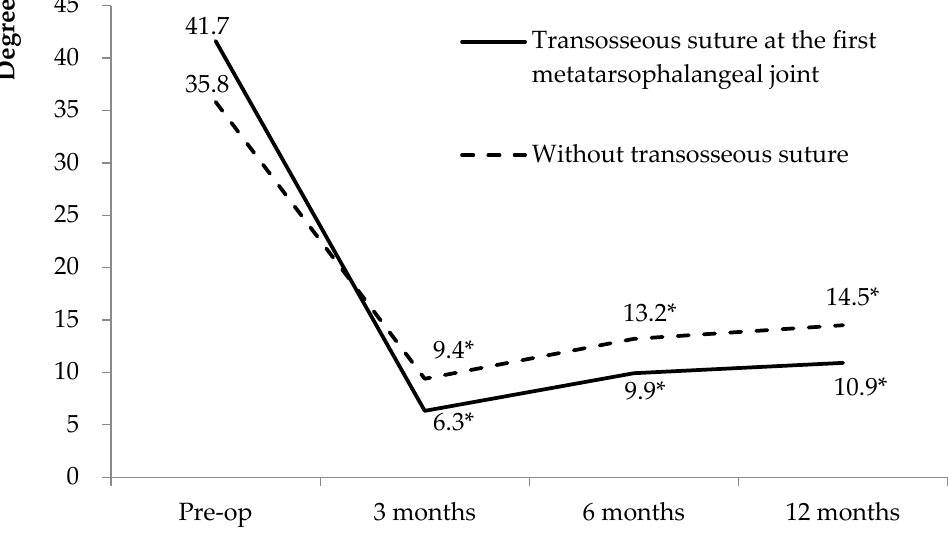
Figure 5. Comparison of the HVA between those with and without medial capsuloligamentous aug- mentation at the first metatarsophalangeal joint. * Compared with the baseline parameters, p <